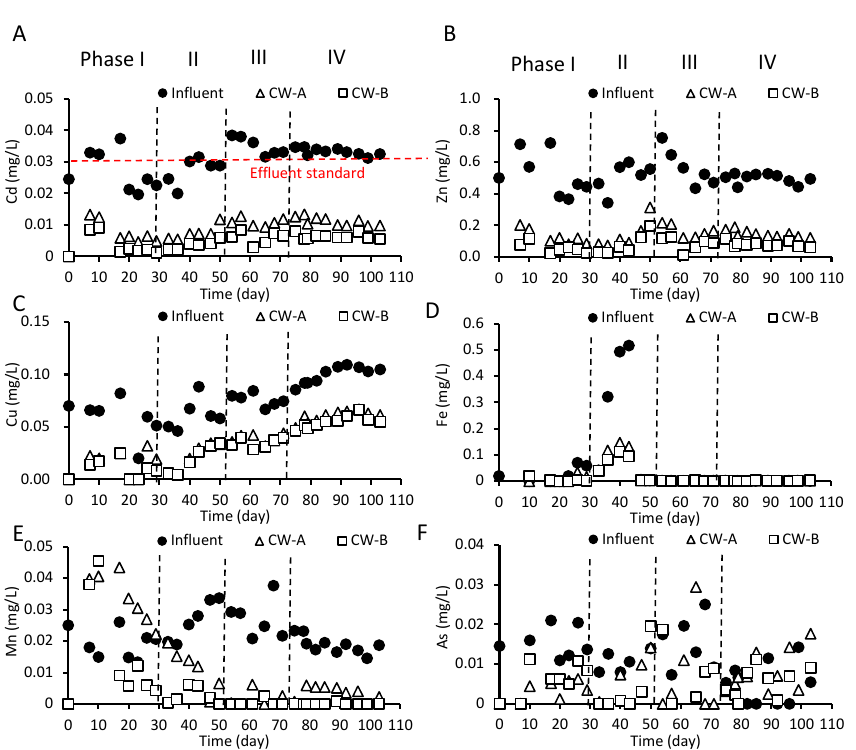
Figure 3. Time courses of metal concentrations in influent and effluent in unplanted CW (CW-A) and cattail-planted CW (CW-B) treating NMD: Cd ( A ), Zn ( B ), Cu ( C ), Fe ( D ), Mn ( E ), and As ( F ).